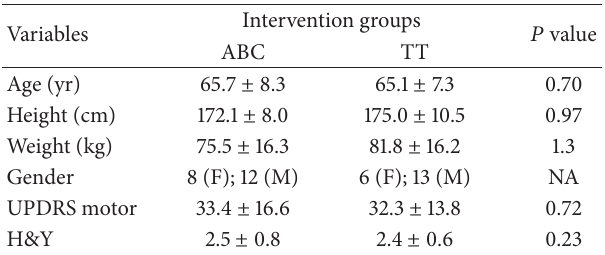
Table 1: Participant